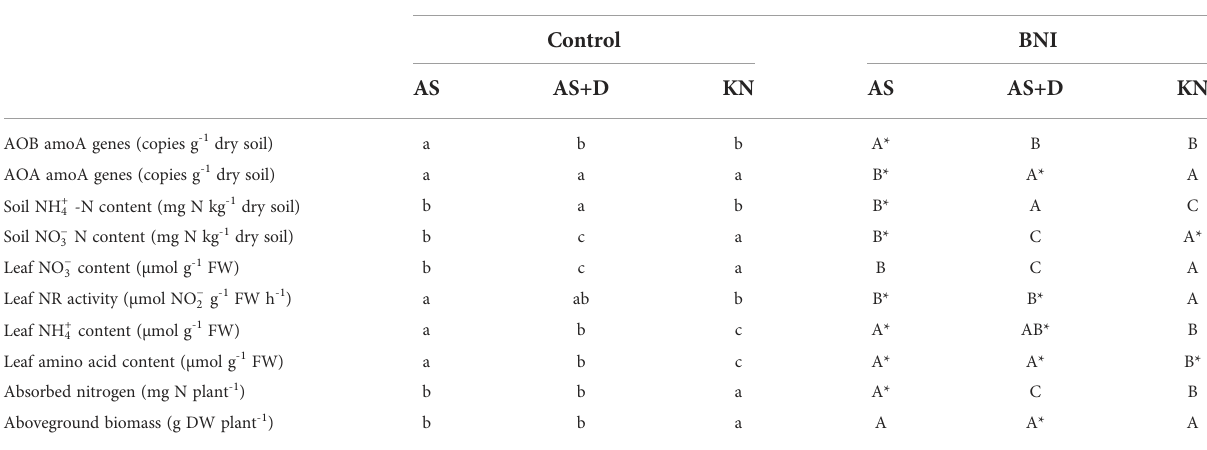
TABLE 3 Statistical analysis of measured parameters in ROELFS Control and BNI-isogenic-lines.